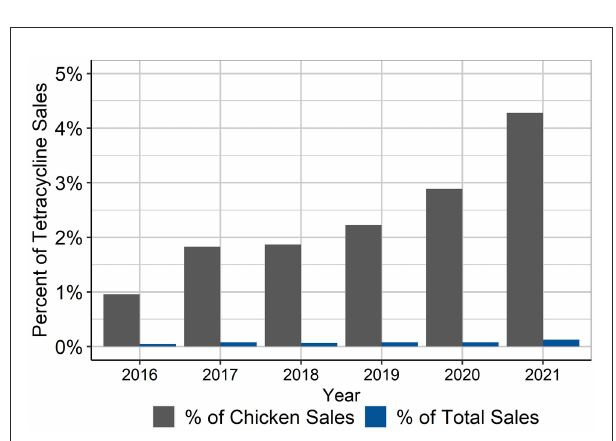
FIGURE3 Percentage of tetracycline sales in U.S. animal agriculture that is represented in the CTC use in layers in this dataset, 2016–2021 (5). Estimates are shown for percentage of tetracyclines sold for use in chickens and for all food-producing